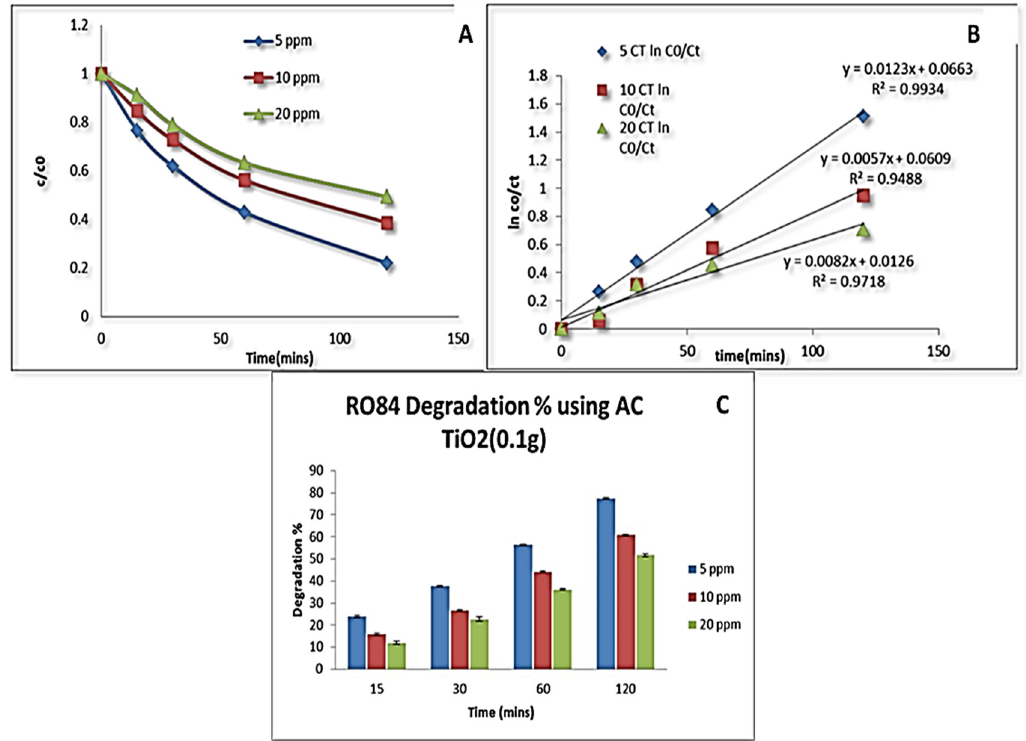
Figure 6. ( A , B ) Degradation kinetics of RO84 with AC-TiO 2 (0.1 g). ( C ) Degradation percentage of RO84 using AC-TiO 2 (0.1 g).